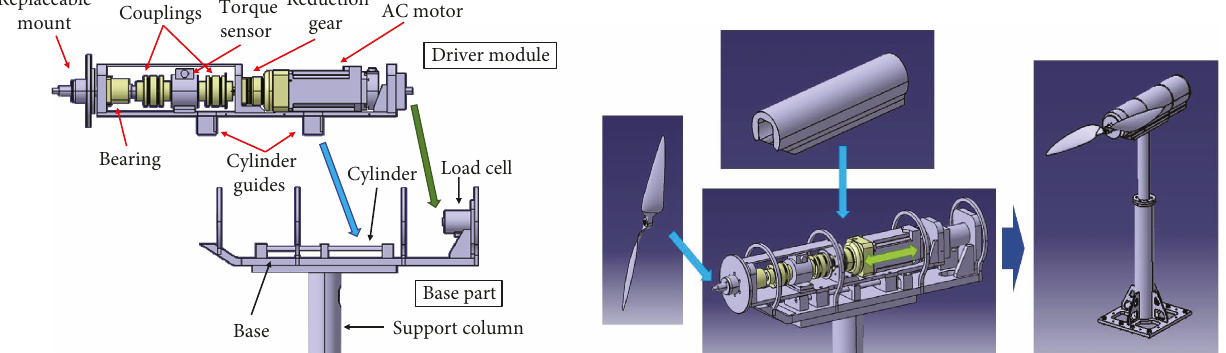
Figure 14: Schematic and modeling of measurement